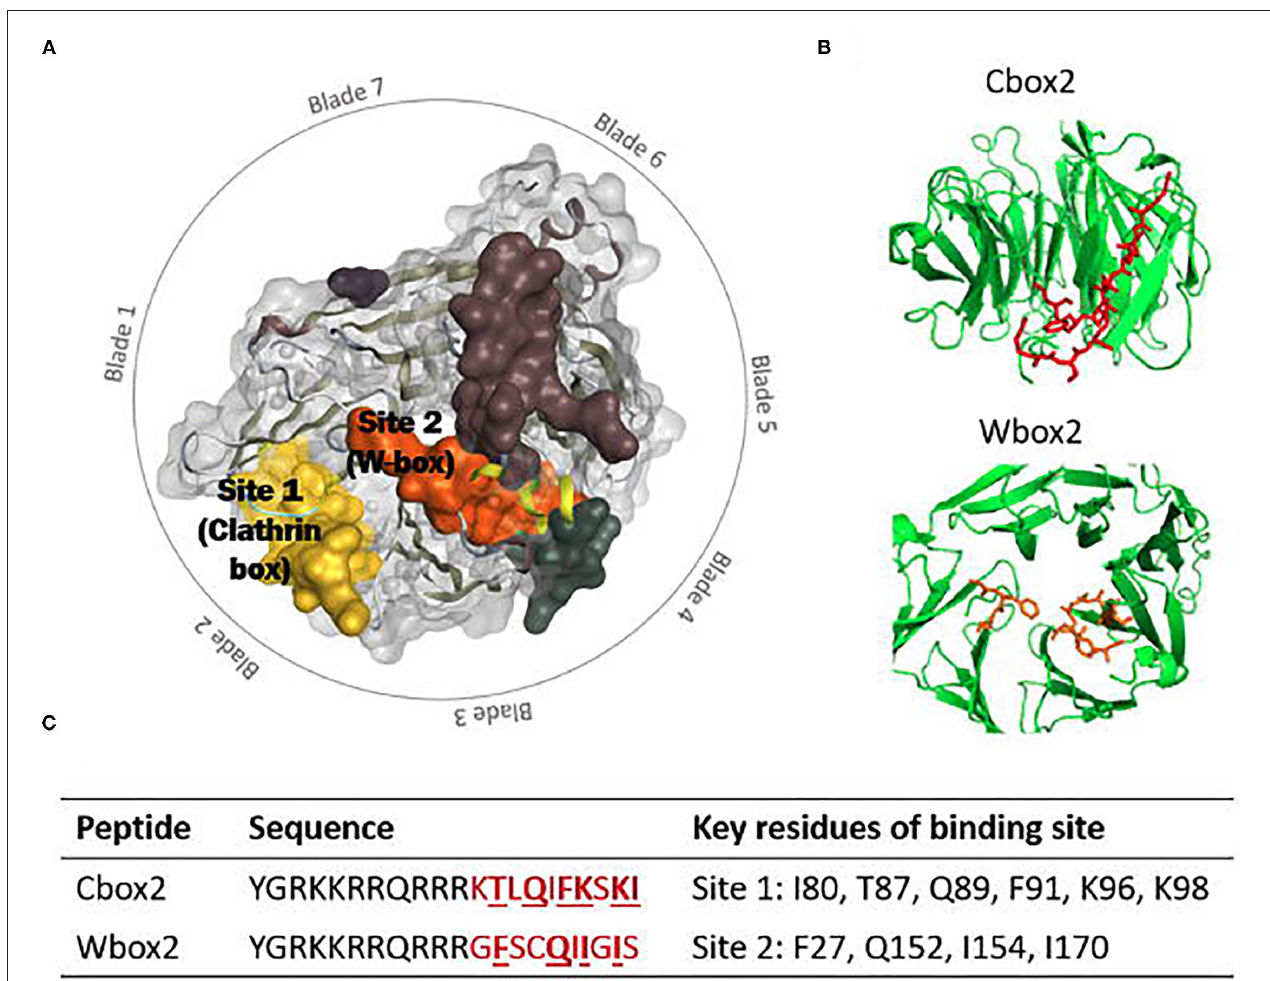
FIGURE 9 | (A) Top view of the CTD, showing the binding sites of interest; Site 1 (clathrin box) in yellow and Site 2 (W-box) in orange (Ter Haar et al., 1998). (B) Amino acid sequences of Cbox2 (red) and Wbox2 (orange) shown on the CTD ( Chen et al., 2020). (C) Peptide sequence of Cbox2 and Wbox2, TAT (transactivator of transcription) sequence in black and CTD derived amino acids in red. Bold and underlined are the key resides (corresponding to the key residues of Site 1 and 2) (Chen et al.,